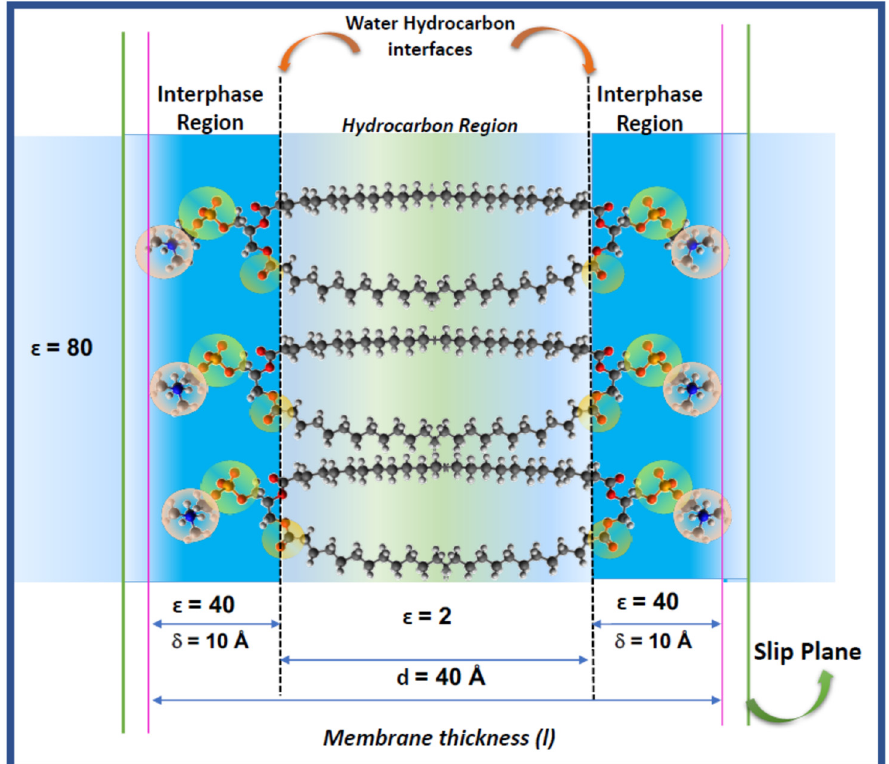
Figure 1. The bidimensional solution model for lipid membrane. The interphase region consists of a solution of polar head groups and its hydration shell (circles) immersed in water (blue region) of different properties than the bulk (light blue). In this region, constituent dipoles such as CO and PO groups are oriented in different directions. Details of water dipoles are not included for simplicity. The ascribed value for the dielectric permittivity at the different regions is denoted. The total thickness is obtained as l = 2 δ + d, where δ is the thickness of the interphase and d the thickness of the hydrocarbon region. The region denoted by δ is that in which the electrical double layer (EDL) is formed. For details see text [8–11].